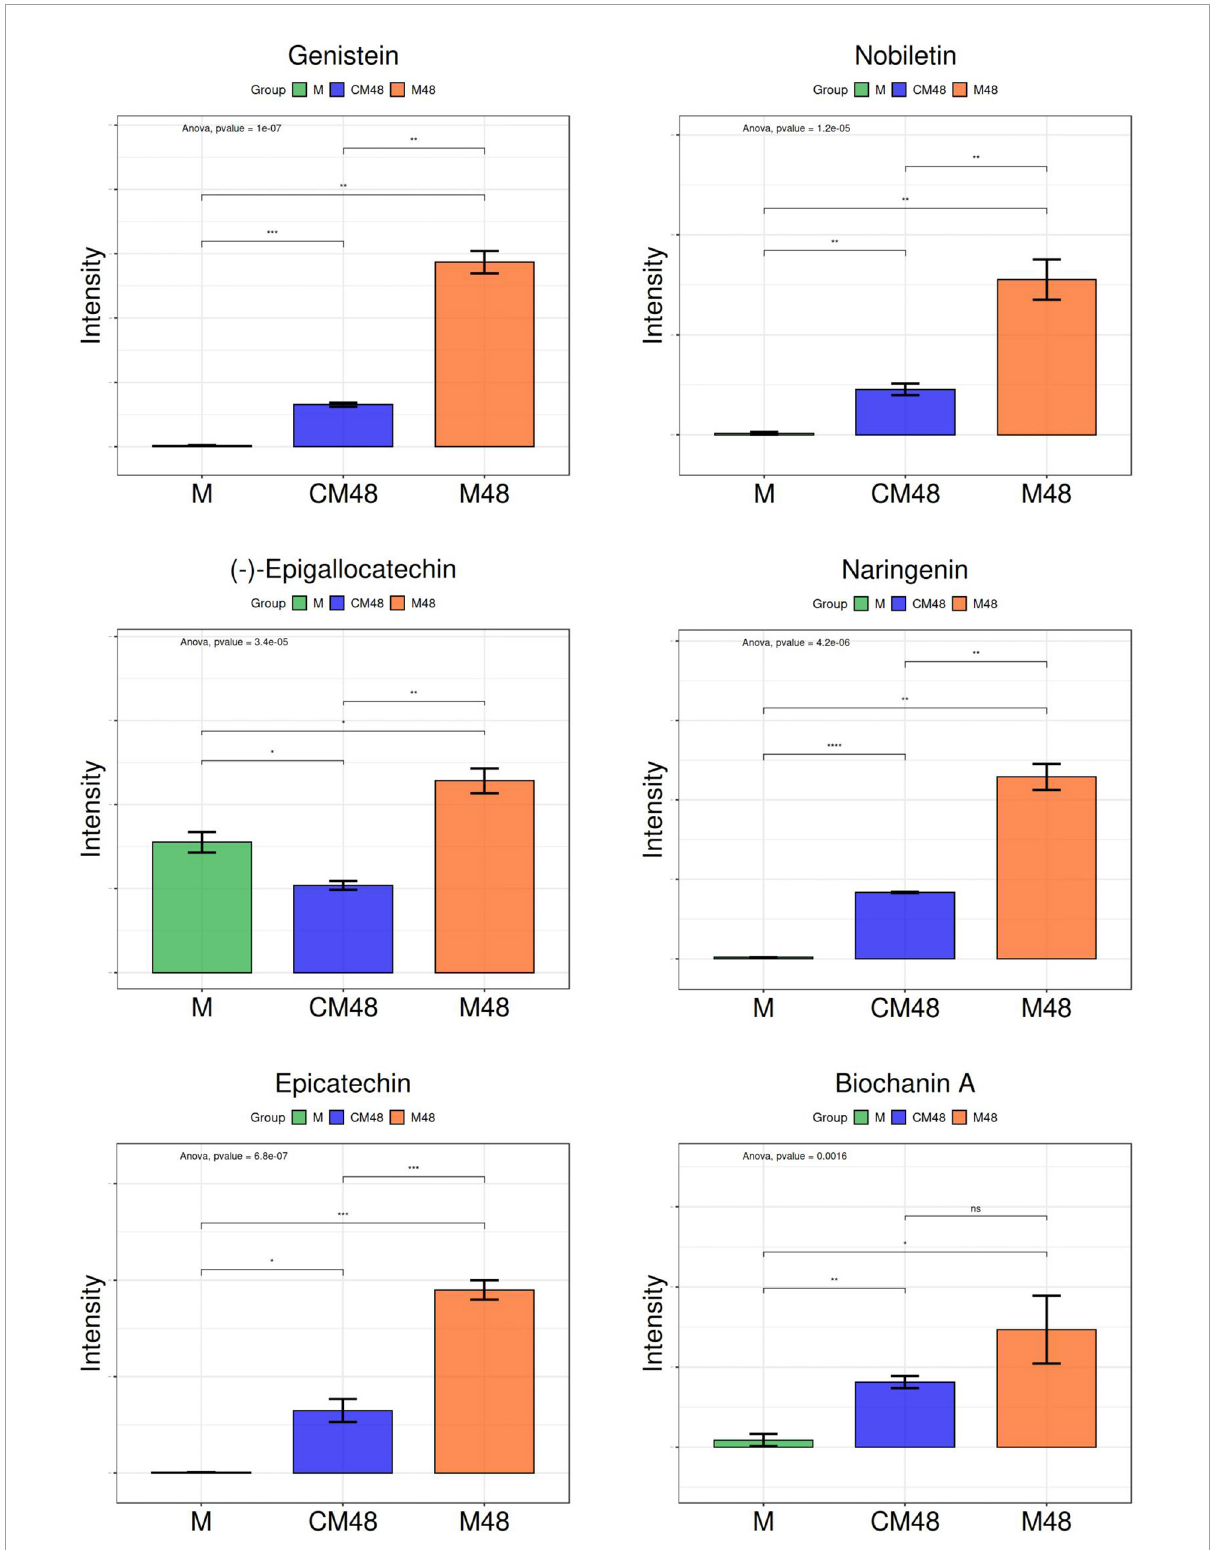
FIGURE8 Changes in polyphenols of germinated mung beans. M, untreated mung bean; CM48, mung bean germinated for 48 h; M48, mung bean pretreated with a combination of ultrasonic and γ -aminobutyric acid (GABA) and germinated for 48 h.